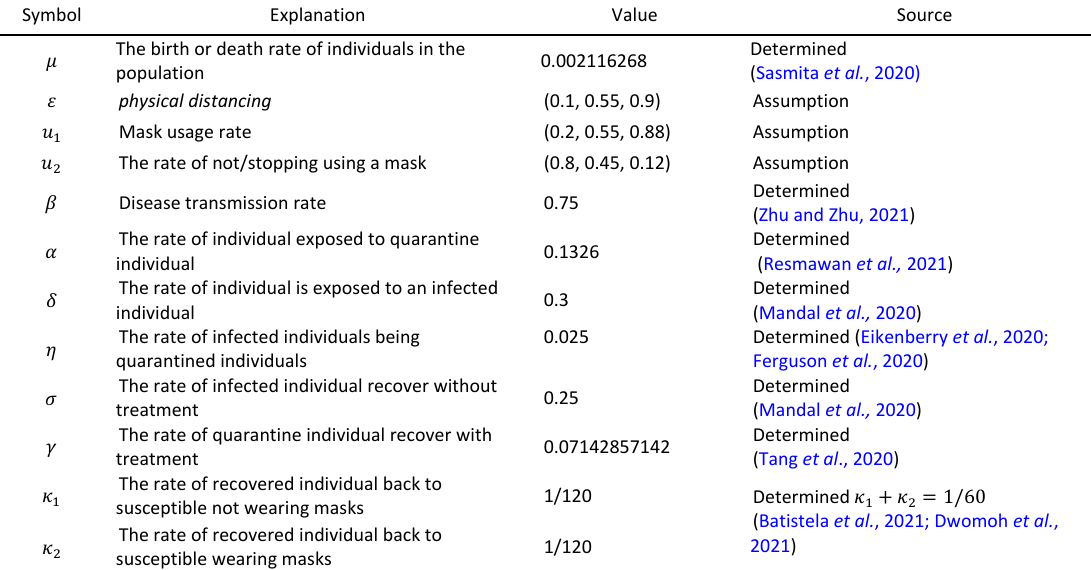
Table 2: COVID-19 spread model parameters